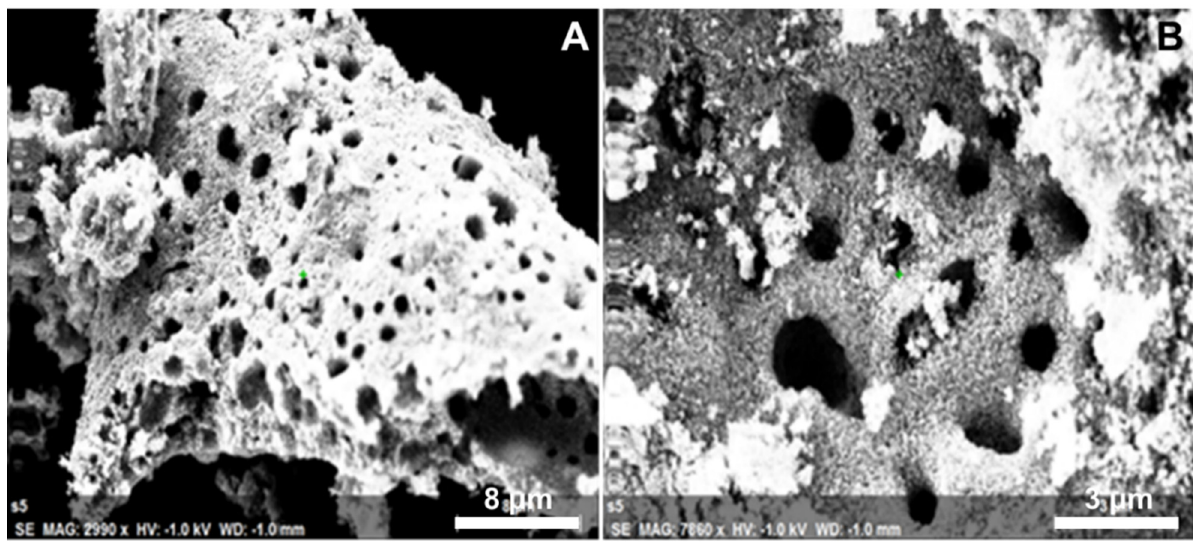
Molecules 2021 , 26 , x FOR PEER REVIEW Figure 4. SEM images of the as-synthesized ZnO-GS NPs. Figure 4. SEM images of the as-synthesized ZnO-GS NPs.